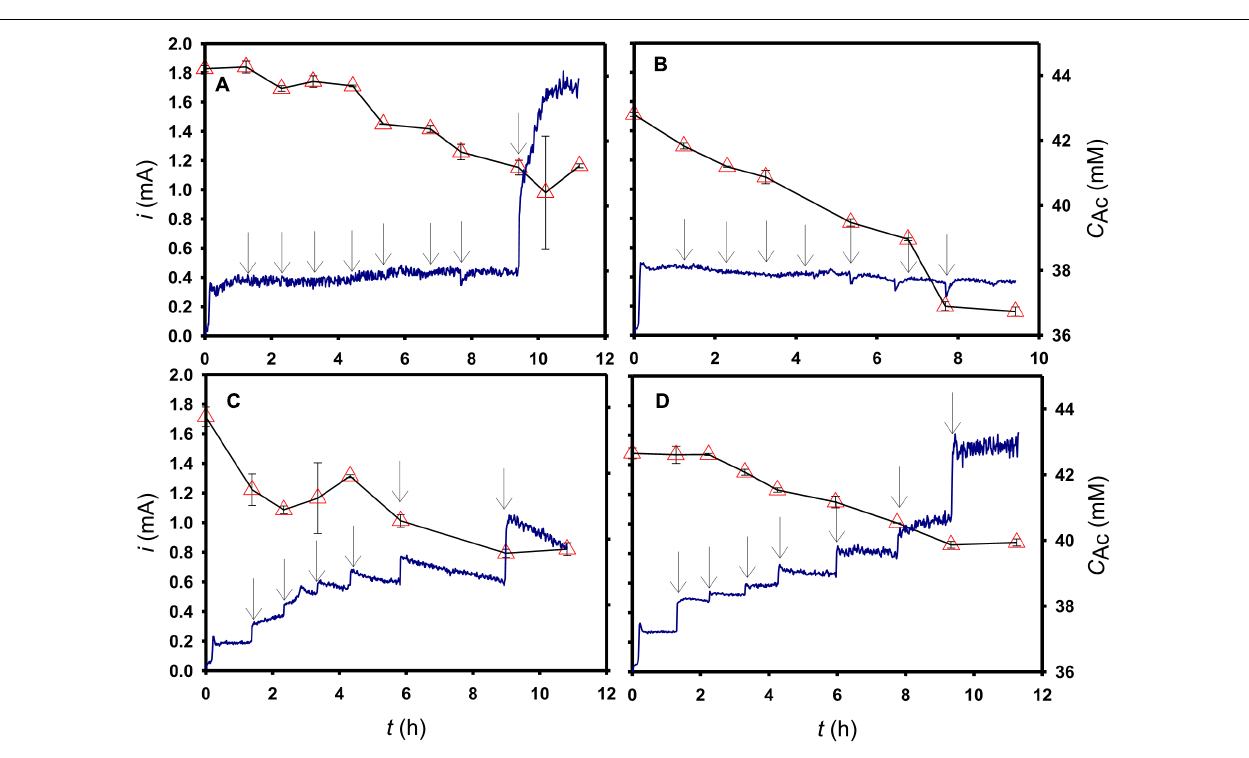
FIGURE 3 | Time course profiles of the electric current (sold line) and the acetate concentration (open triangle) obtained with different mediator spikings: (A) riboflavin, (B) AQDS, (C) Ru(NH 3 ) 63 + , and (D) Fe(CN) 63 − spiked during the chronoamperometric processes. The arrows in (A) indicate the 0.5, 1, 2, 4, 8, 12, and 22 µ M riboflavin, and 100 µ M Fe(CN) 63 − in turn in the electrochemical cell; the arrows in (B) and (D), respectively, indicate the AQDS and Fe(CN) 63 − concentrations of 0.5, 1, 2, 4, 8, 12, and 22 µ M in turn; the arrows in (C) indicate the Ru(NH 3 ) 63 + concentrations of 0.5, 1, 2, 4, 8, and 18 µ M in